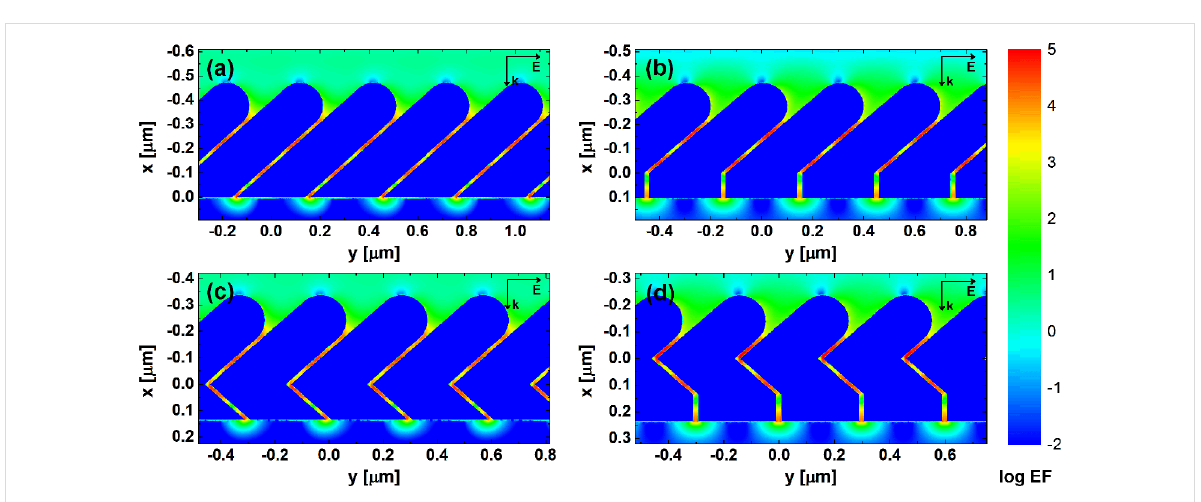
Figure 4: EF distributions obtained from DDA calculations for AgNR 2D hexagonal arrays of different structures with AR = 3.5: (a) S42, (b) S0:42, (c) S − 42:42, (d) S0: − 42:42. The colour bar is at log scale. The excitation wavelength is 632.8 nm and the polarization is parallel to the y -direction. All internal fields are set to 0.01 for visual clarity.